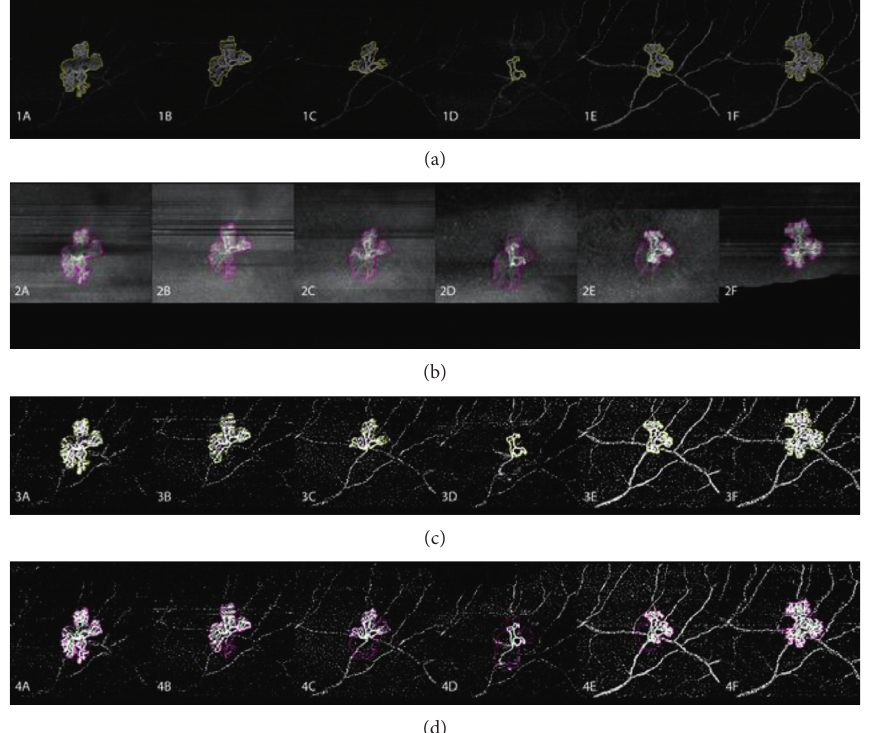
Figure 5: Exemplary follow-up measurements of one neovascularization (NV) with initial regression and later recurrence after cessation of anti-VEGF treatment, as described in the case presentation section, equivalent to the NV in Figure 4 and NV2 in the graphs of Figures 3(a)– 3(d). (a) The optical coherence tomography angiography (OCTA) en face angio image with the outline of NV-angio. (b) The OCTA en face structural image with the outline of NV-structure. (c) The binarized OCTA en face angio image with the outline of NV-angio from (a), visualizing flow density (FD) within the angio area (en face FD-angio). While the angiographic size of the NV regresses, the relative flow density remains high. (d) The binarized OCTA en face angio image with the outline of the NV-structure from (b) (en face FD-structure). While the structural area remains relatively stable, its flow density reduces. Recurrence of the NV occurs within the preexisting structural area of the NV. Column A is at baseline, column B is after one week, and column C is one month after the first anti-VEGF injection. Column D represents 22 weeks from baseline, one month after the fourth injection and at the minimal dimensions of NV. Column E shows early recurrence 32 weeks from baseline, 20 weeks after the last injection. Column F shows subtotal recurrence 37 weeks from baseline and 25 weeks after the last anti-VEGF injection, when recurrent vitreous hemorrhage on the fellow eye had occurred, and before retreatment. After retreatment a similar regression was